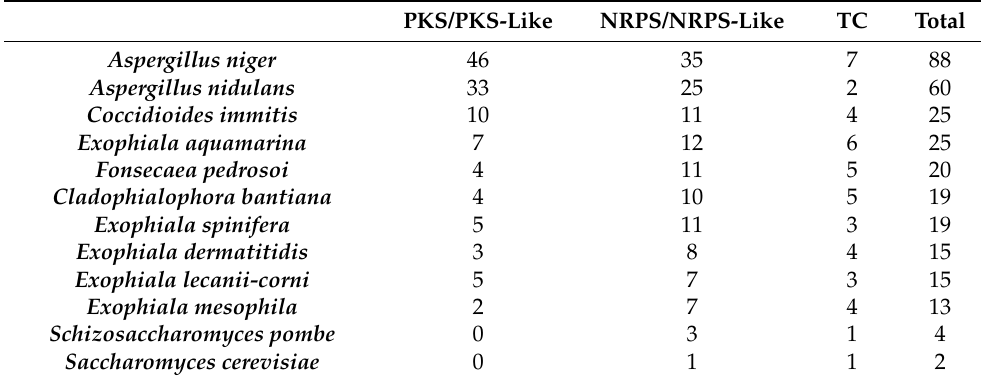
Table 5. Count of secondary metabolite core synthase genes in the genomes of E. lecanii-corni and other ascomycetous fungal